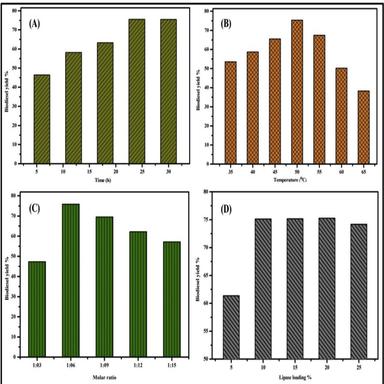
Optimization of various parameters on biodiesel production for the effect: (A) time at constant reaction parameters temperature: 50 ± 1 C, 10% hybrid bio-supported catalyst on oil weight, 6:1 (propan-2-ol to Castor oil ratio); (B) temperature at constant reaction parameters: 6:1, molar ratio, 10% hybrid BSC on oil amount, and 24 h; (C) molar ratio at constant reaction parameters: 50 ± 1 C, 10% hybrid BSC on oil weight, and 24 h; (D) immobilized hybrid BSC (wt% on oil weight) at constant reaction parameters: